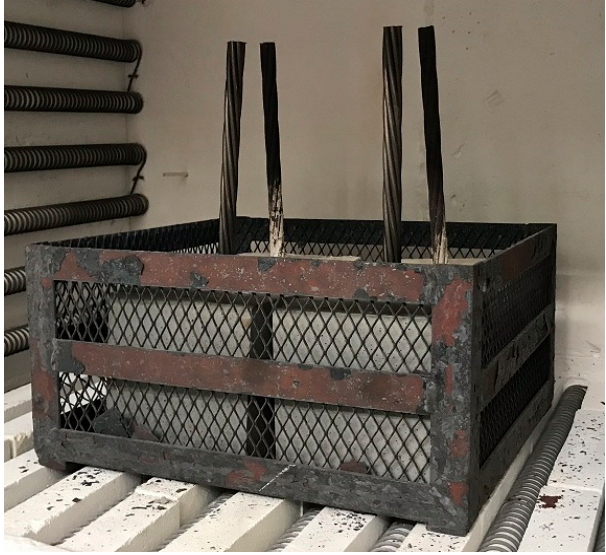
Figure 6. Example of the UHPC samples with prestressing reinforcement in the furnace.